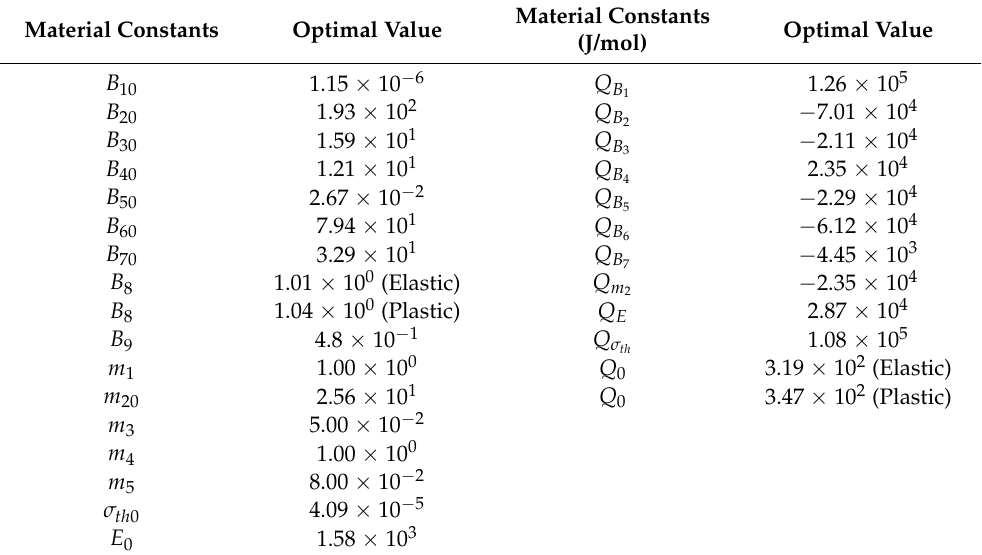
Table 4. Determined values of material constants in the stress relaxation